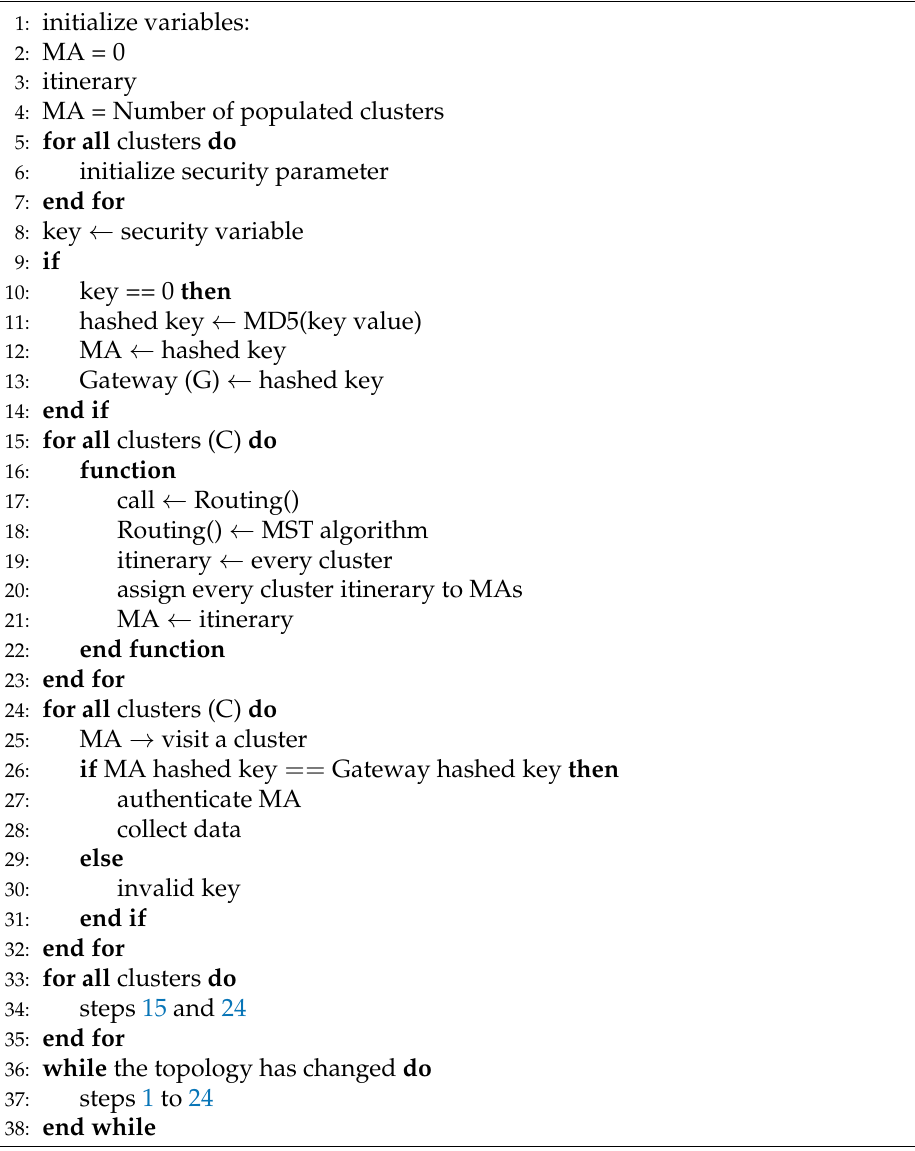
Algorithm 3 Dynamic itinerary planner